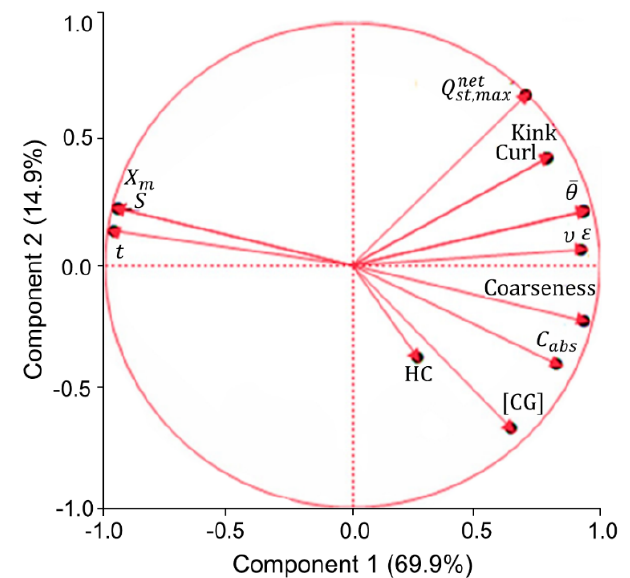
Figure 6. Principal component analysis (PCA) diagram elucidating the structure-property relationships of kraft fluff pulps 1 – 6 .